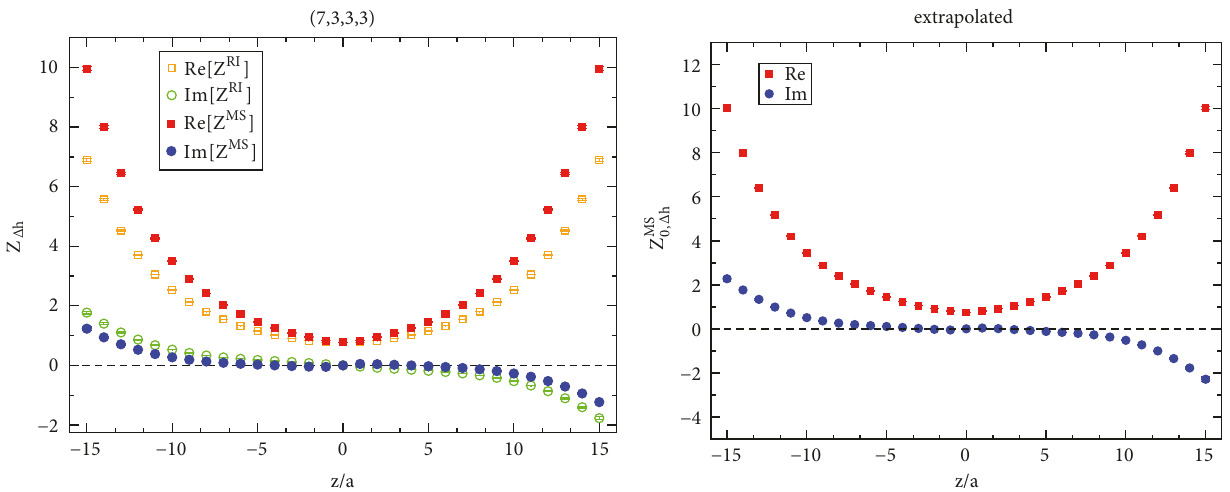
Figure 15: Left: the 𝑧 -dependent renormalization function for the axial nonlocal operator at an RI 󸀠 scale of (𝑎𝑞) 2 = 1.6 . Open (filled) symbols correspond to the RI 󸀠 (MS) estimates. Right: extrapolated renormalization function using a fit range for the RI 󸀠 scale of (𝑎 𝜇 0 ) 2 𝜖 [1.4 – 2.0] . Source: [151], reprinted with permission by the Authors (article available under CC BY).